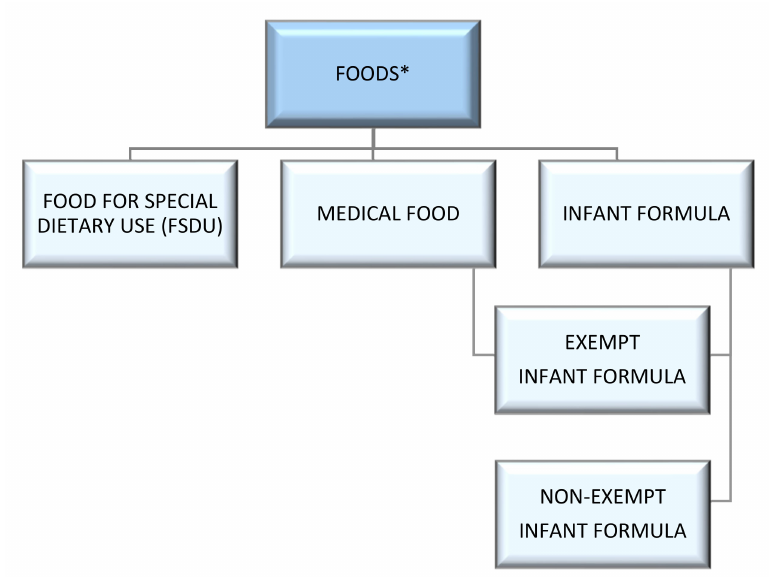
Figure 1. Specialized product categories in the United States. * Foods are regulated by the Food and Drug Administration (FDA) Code of Federal Regulations